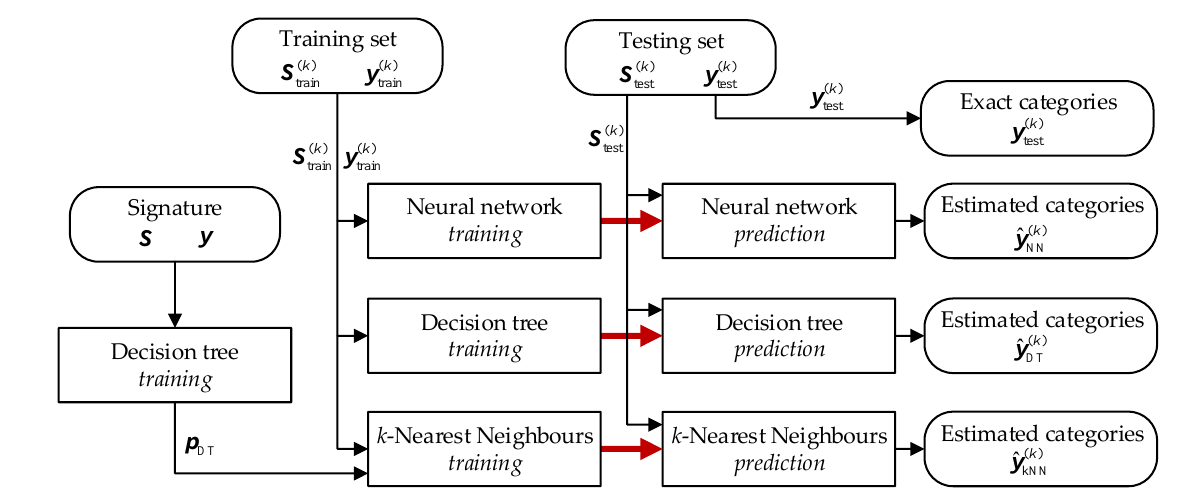
Figure 16. Detailed diagram of one cross-validation attempt.